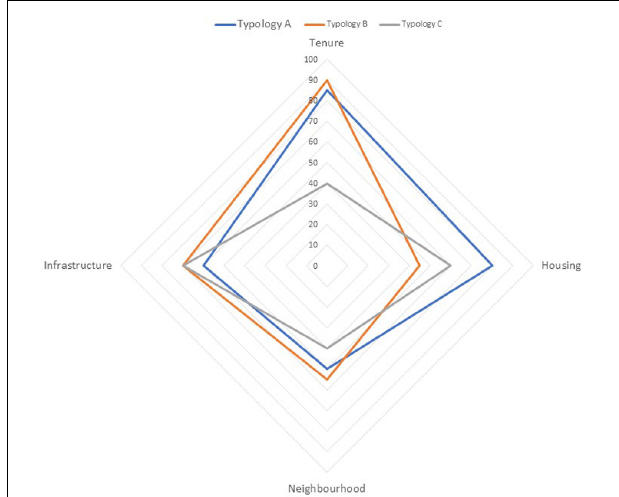
FIGURE 4 | Case example of Living Conditions Diamond